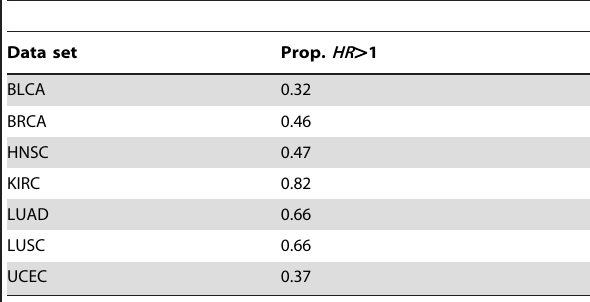
Table 5. Directionality of significant network edges.